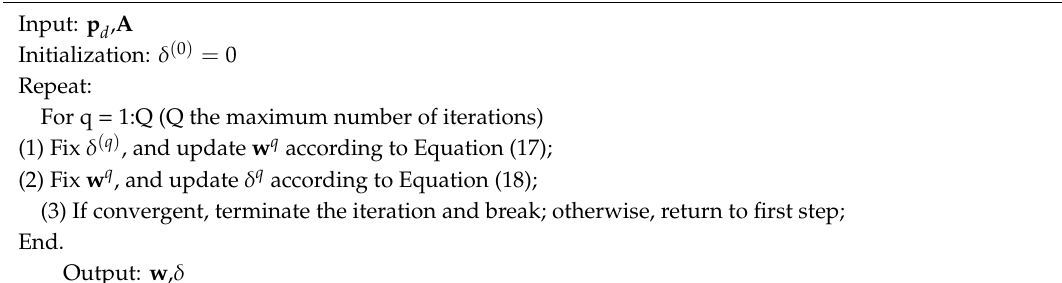
Algorithm 1 Procedure of the proposed algorithm.